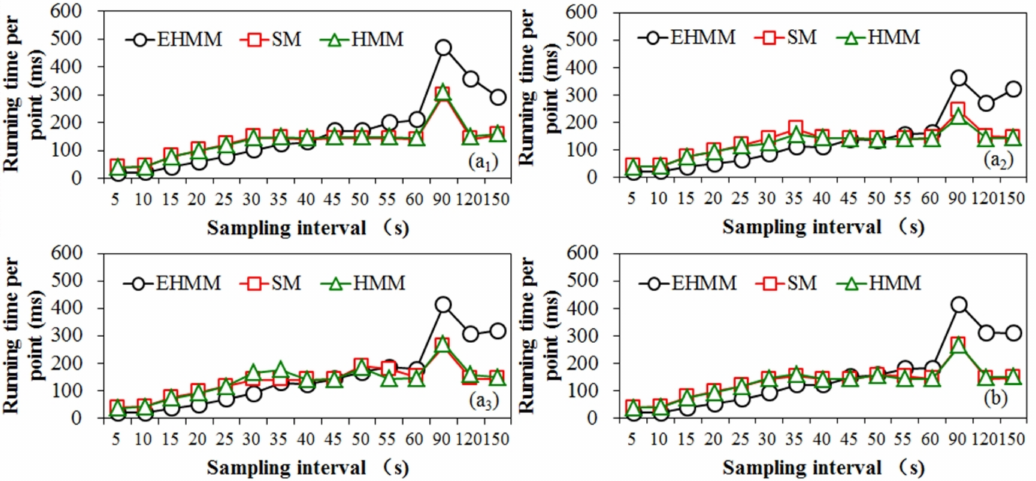
Figure 9. Comparison of running times for various sampling intervals based on dataset 1. In ( a ), subscript numbers 1, 2 and 3 represent the first sampling, second sampling and third sampling, respectively, in dataset 1. ( b ) represents the average running time among the three samplings.